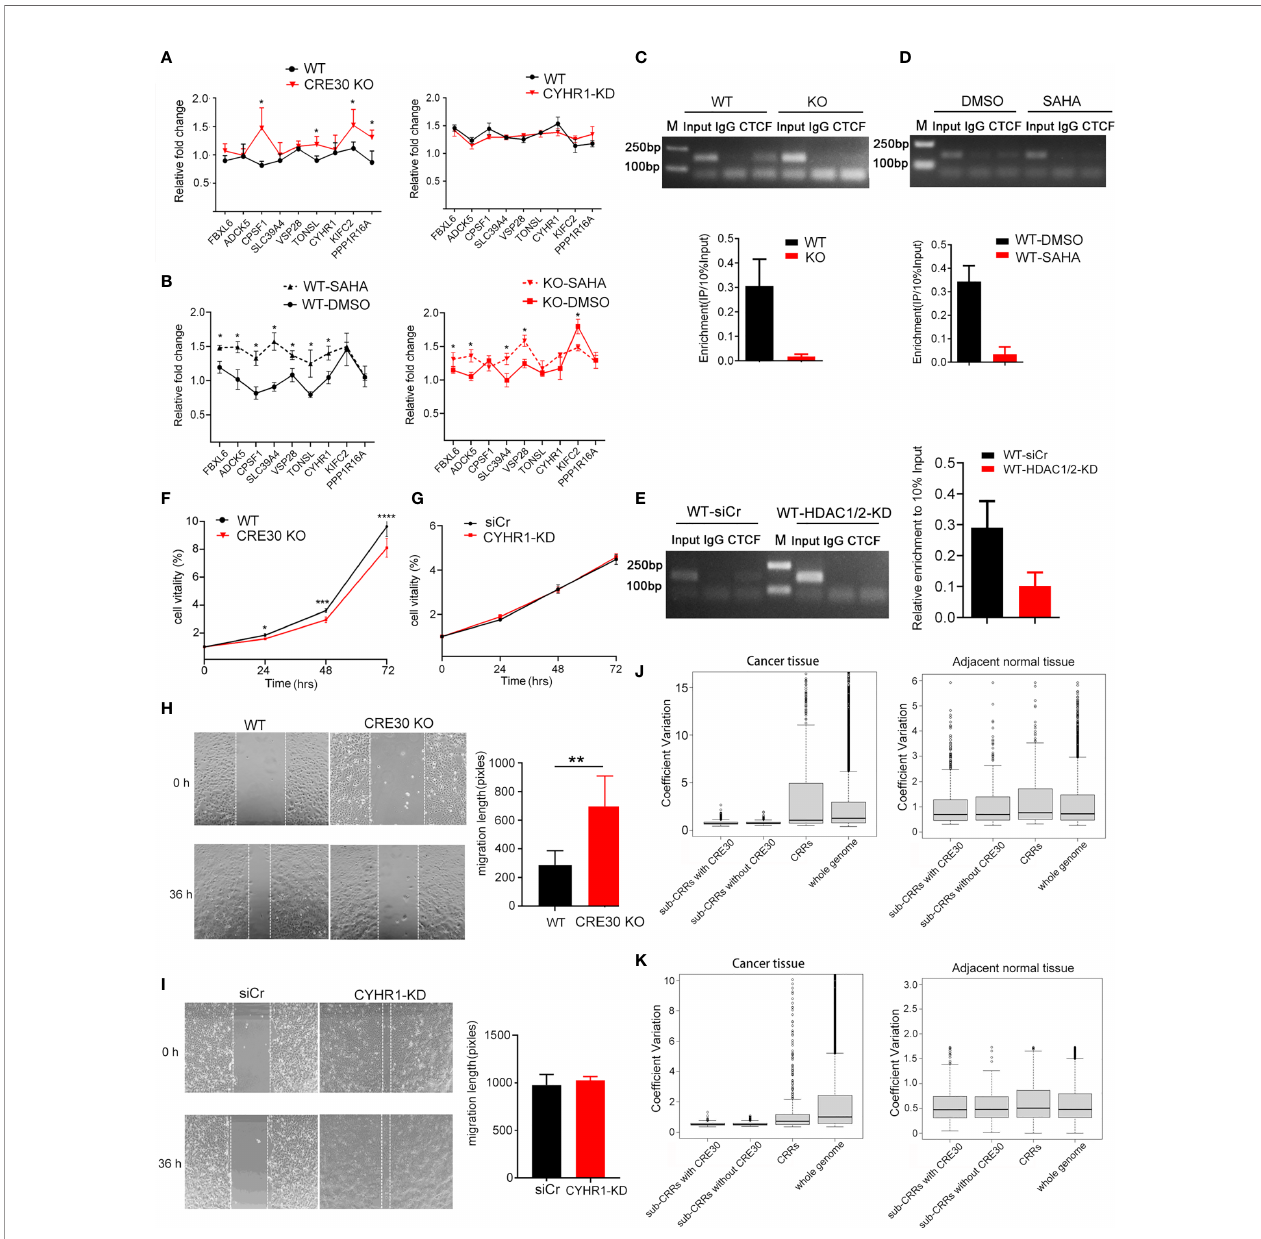
FIGURE 6 | CRE30 exhibited similar effects in other sub-CRRs in cancer genomes. (A) In the sub-CRR96 region, qPCR assay showed an increase of gene upregulation scope in CRE30-deleted Ishikawa cells (left panel), while CYHR1 knockdown only had modest changes (right panel) (n ≥ 3). (B) In the sub-CRR96 region, treatment with SAHA induced signi fi cantly larger gene regulation in wild-type Ishikawa cells (black dotted line, left panel), while the gene regulation scope showed a smaller increase in CRE30 deletion cells (red dotted line, right panel), n = 3. (C) CTCF ChIP-PCR con fi rmed CTCF binding at the CRE30 locus in sub- CRR96, and binding decreased with CRE30 deletion (n = 3). Asterisks indicate the signi fi cant differences. (D, E) ChIP-PCR results showed a decline of CTCF binding at the sub-CRR96 CRE30 locus in response to SAHA treatment (D) and HDAC1/2 knockdown (E) in Ishikawa cells (n ≥ 2). (F, G) MTT assays for Ishikawa cells indicated decreased cell proliferation in sub-CRR96 CRE30 deletion cells (F) , but not in CYHR1 knockdown cells (G) (n ≥ 6). (H, I) Wound healing assay for Ishikawa cells suggested CRE30 deletion (H) at the sub-CRR96 locus induced a signi fi cant decline in cell migration, while no difference was observed with CYHR1 knocking down (I) (n ≥ 4). (J, K) Boxplot analysis of CVs of genes in and outside of CRRs\sub-CRRs\sub-CRRs with CRE30. Expressional coef fi cient of variations (CVs) of each gene was calculated using UCEC [ (J) left], CESC[ (K) left], and adjacent normal tissue [ (J, K) right] data. Genes were divided into four groups: genes in sub-CRRs with CRE30, genes in sub-CRRs without CRE30, genes in CRRs (sub-CRR genes excluded), and genes in whole genome (all CRR genes excluded). The CVs of each group were box plotted. T-tests were performed, and signi fi cant differences were indicated by ** (p <